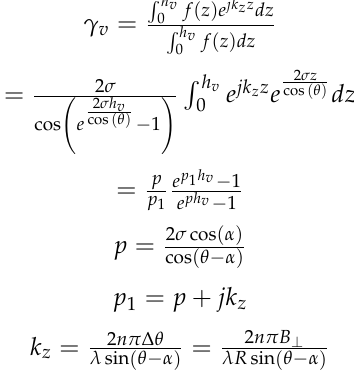
Table 2. Summary of UAVSAR data.